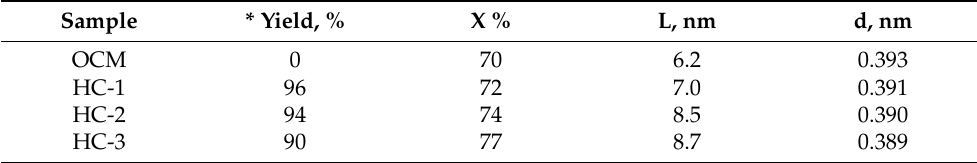
Table 1. Characteristics of crystalline structure of cellulose samples.